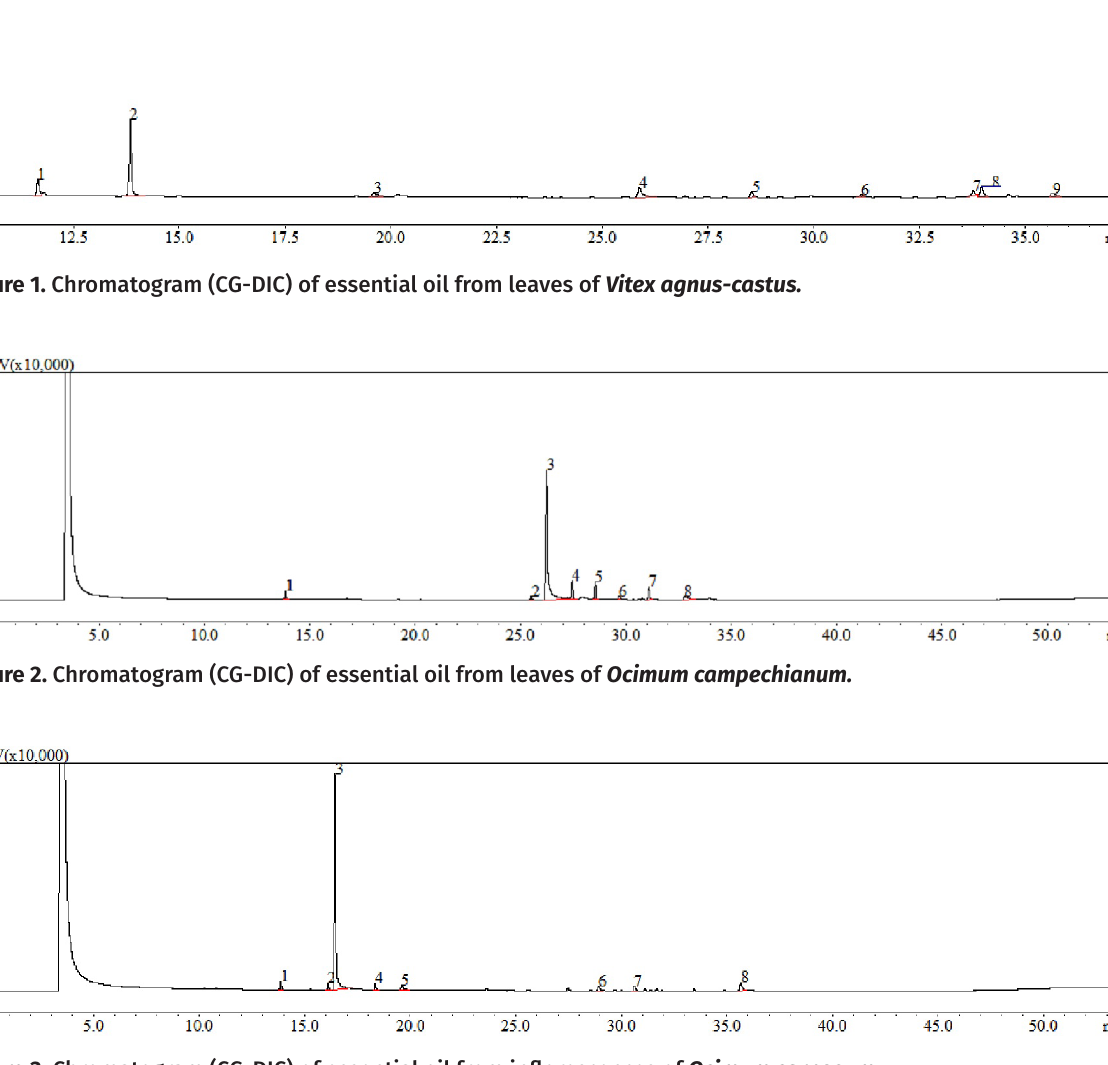
Figure 3. Chromatogram (CG-DIC) of essential oil from inflorescences of Ocimum carnosum.